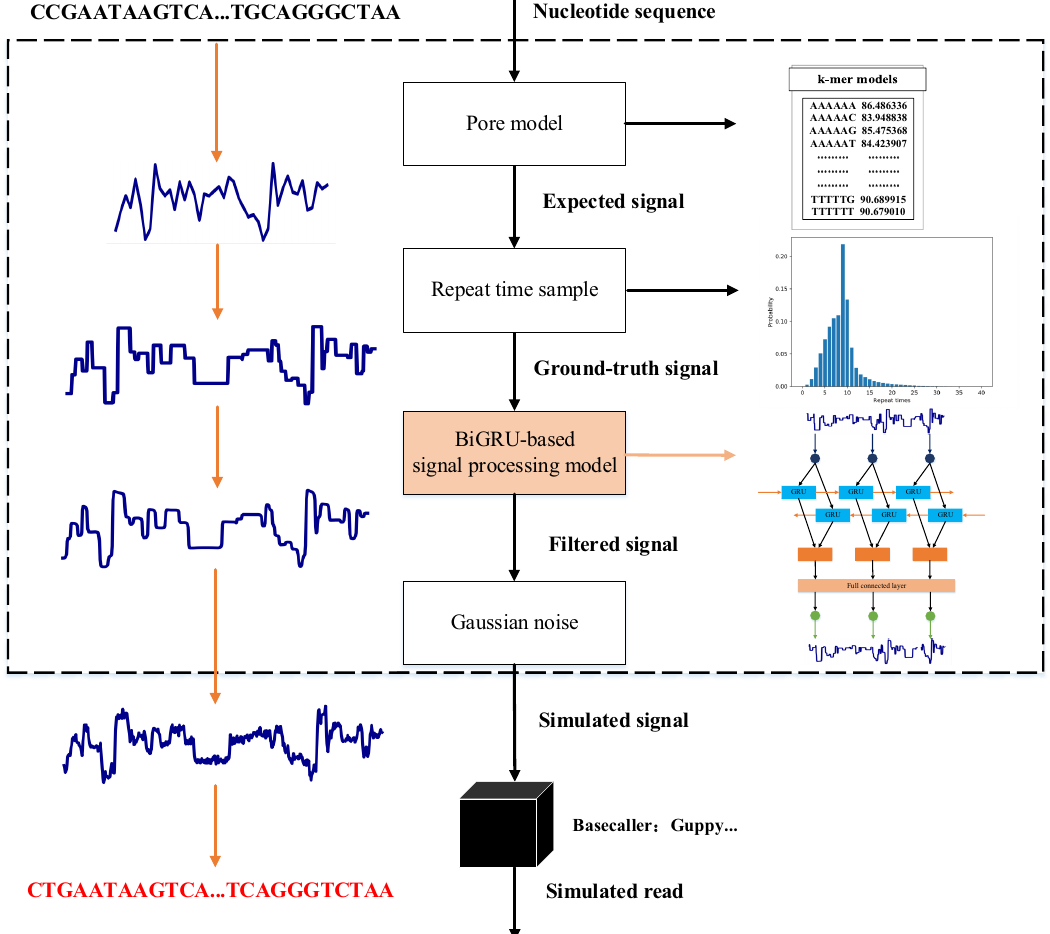
Figure 1. The main workflow of the proposed signal simulation method based on BiGRU (NanosigSim). Given an input nucleotide sequence, this method first generates the expected signal by the pore model. Then, the expected signal is used to produce the ground-truth signal according to the repeat length distribution. Finally, to simulate the real-world sequencing signal, it applies BiGRU-based signal processing model and adds the Gaussian noise on the ground-truth